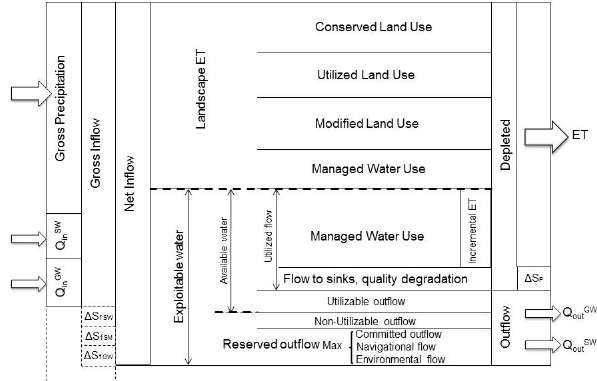
Fig. 2. Schematic presentation of the resource base